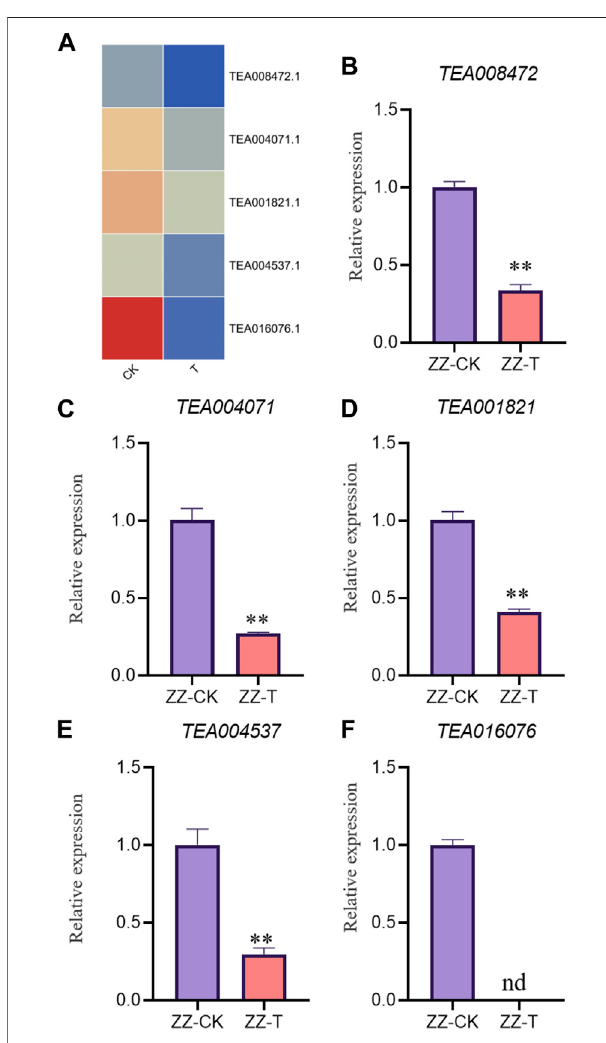
FIGURE 11 | ZZ-CK&ZZ-T Comparison of down genes expression patternbetweenRNA-SeqandqRT-PCRresults.Thegeneexpressionvalues were normalized to the Actin gene. The purple column represents the results of drought treatment for 0 days, and the orange red column represents the results of drought treatment for 20 days. CK: Seeding samples treated withdrought for0 days,T:Seedingsamplestreatedwithdroughtfor20 days. ** p < 0.01, *** p < 0.0001.